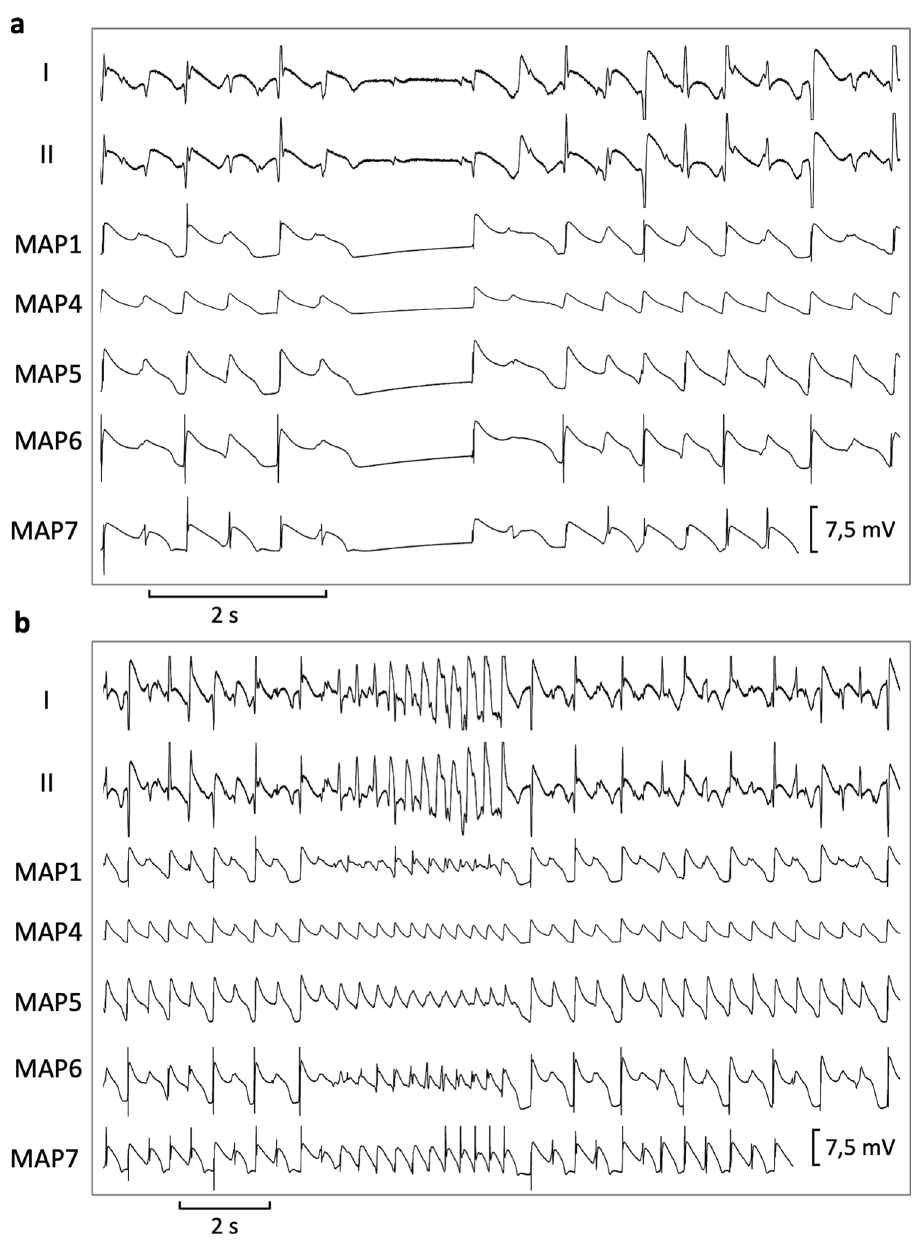
Figure 5. (A) Representative example of early afterdepolarizations ( a ) and torsade de pointes ( b ) induced by erythromycin (MAP = monophasic action